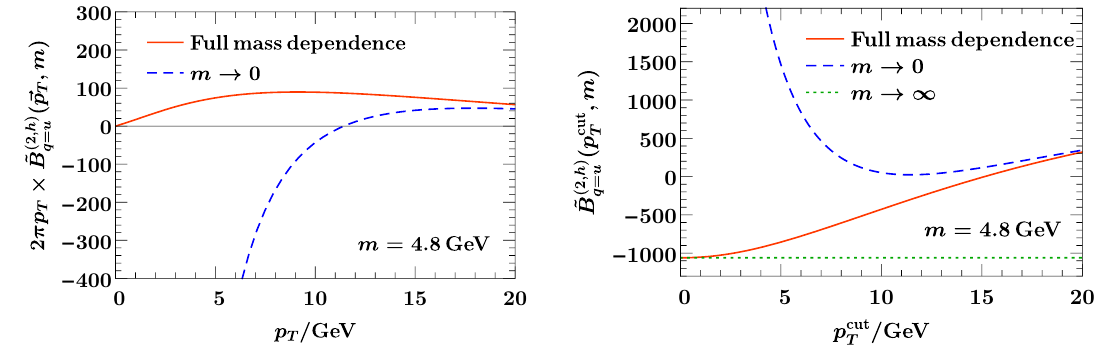
Figure 13 . Secondary massive bottom quark corrections to the u -quark beam function (left panel) and its cumulant (right panel) at for (cid:22) = m b as a function of q T